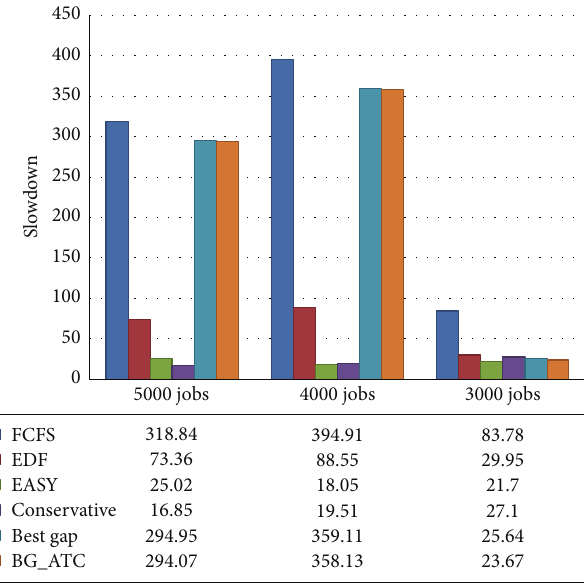
Figure 12: Flow time performance analysis on metacentrum work-